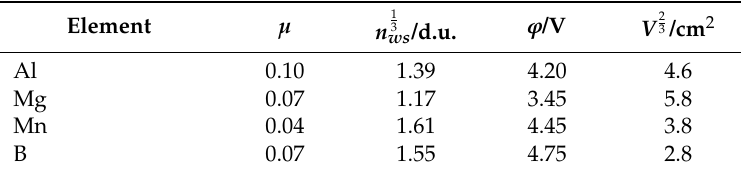
Table 4. Some Miedema model parameters.